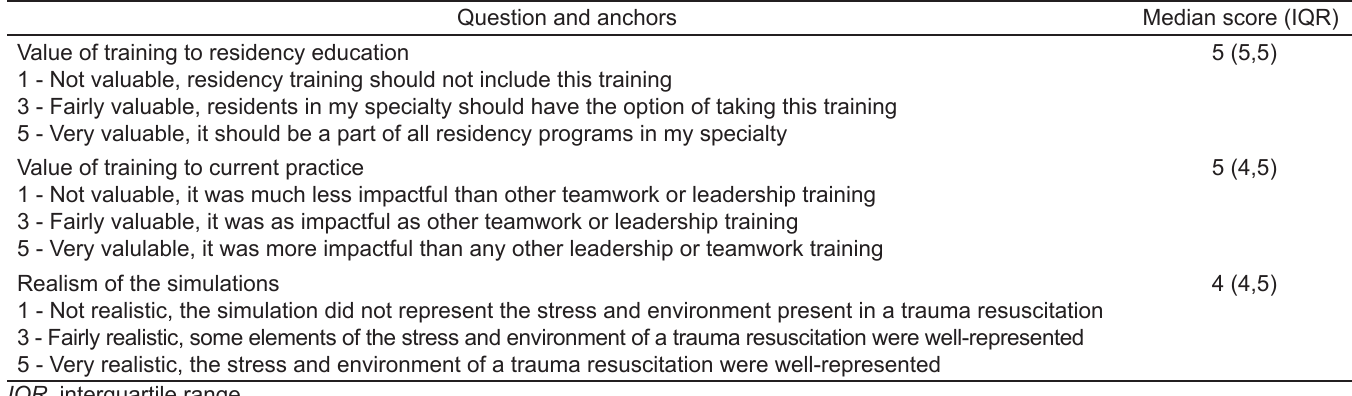
Table 3. Survey results for the perceived value and realism of the simulation-based leadership training.